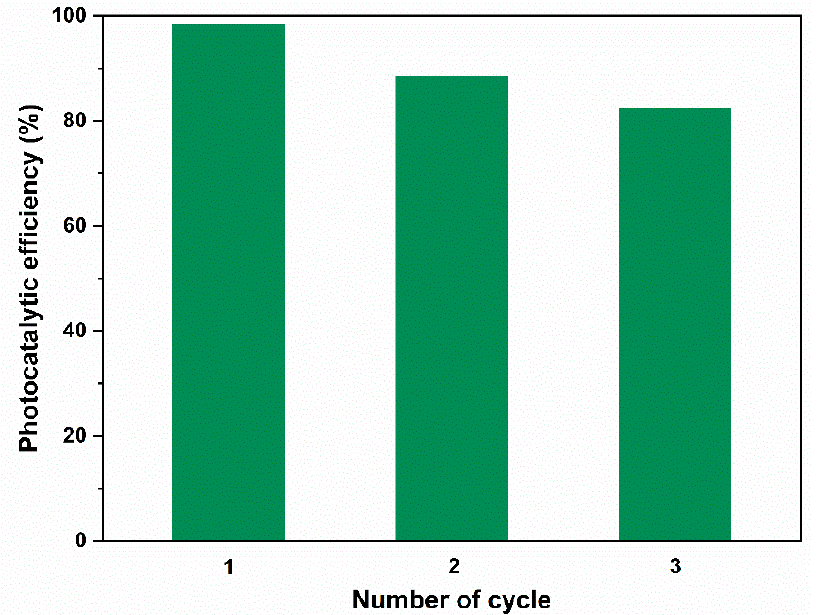
Figure 9. The reusability of the prepared rGO@TiO 2 /CN hybrid in the photocatalytic degradation of RhB dye in Milli-Q water under simulated solar-like irradiation for 120 min.